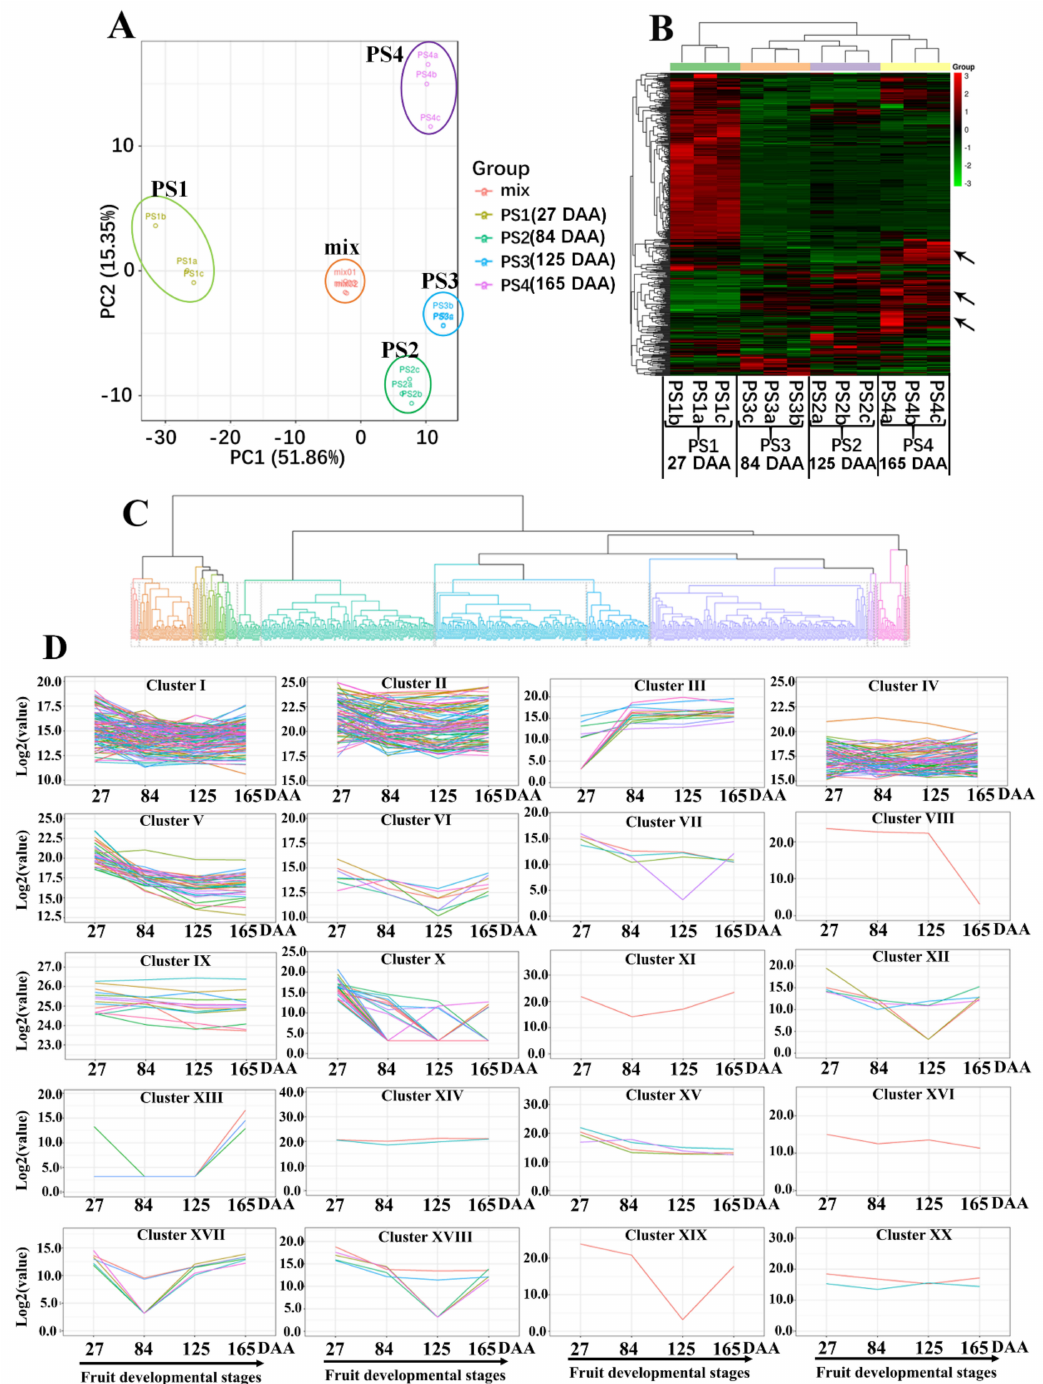
Figure 1. Dynamic metabolome of apple development and ripening: ( A ) Principal component analysis of metabolomics data from four developmental stages of the “Pinova” fruit. “Mix” means the balanced mixture of all fruit samples (quality control). ( B ) A heat map of the identified metabolites in apple at four developmental stages: The colors indicate the relative content of each identified metabolite among the di ff erent developmental stages as determined by the average peak response area by UPLC-MS. ( C ) Clustering analysis of all 462 metabolites according to their variation tendency during four fruit-development stages and ( D ) metabolite variation tendencies among the twenty cluster profiles. PS1, 2, 3 and 4 mean the four apple-development stages: PS1 represents 27 Days After Anthesis (DAA); PS2 represents 84 DAA; PS3 represents 125 DAA; and PS4 represents 165